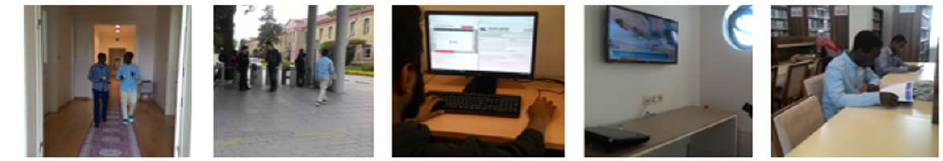
Figure 6. Example photos for “short break”, “active”, “working on a PC”, “watching TV” and “sedentary-context unknown”.